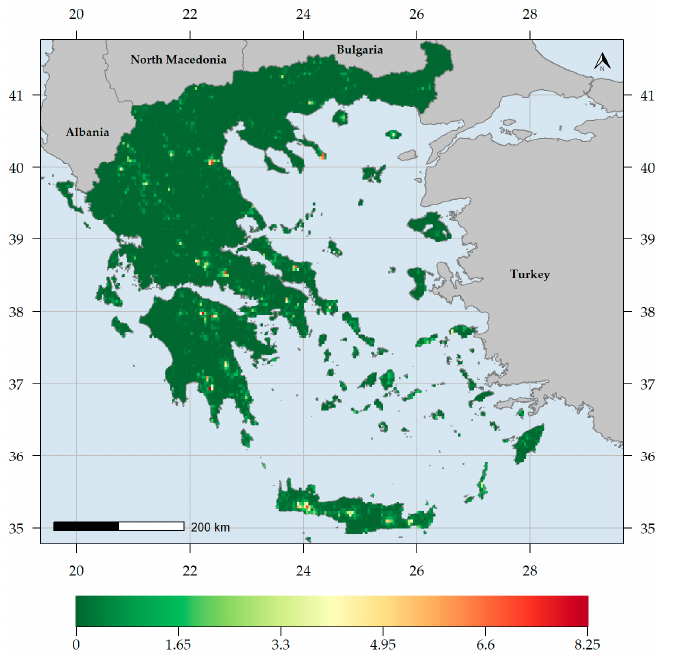
Figure 4. Corrected weighted endemism values for the Greek endemic plant taxa (CWE END ) occur- ring in each grid cell in Greece.